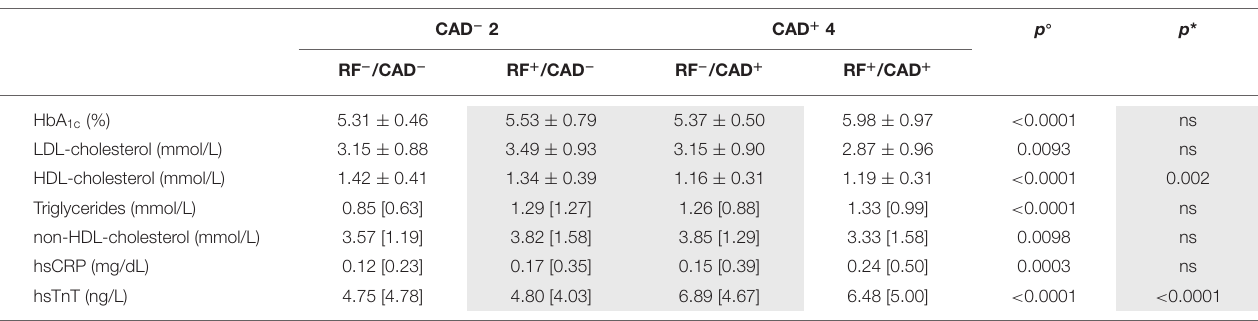
TABLE 2 | Metabolic parameters of the four study groups # .